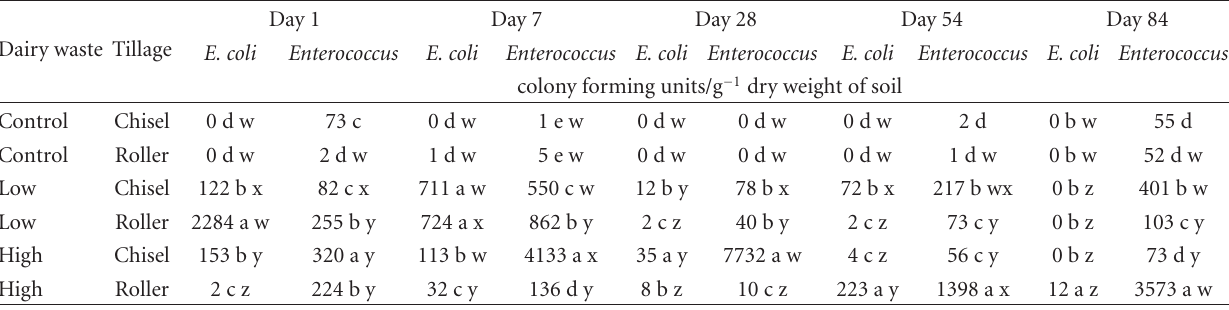
Table 1: Escherichia coli and Enterococcus sp. mean numbers in the 0–5 cm of soil after application of inorganic fertilizer (control) and solid dairy manure and chisel or disc